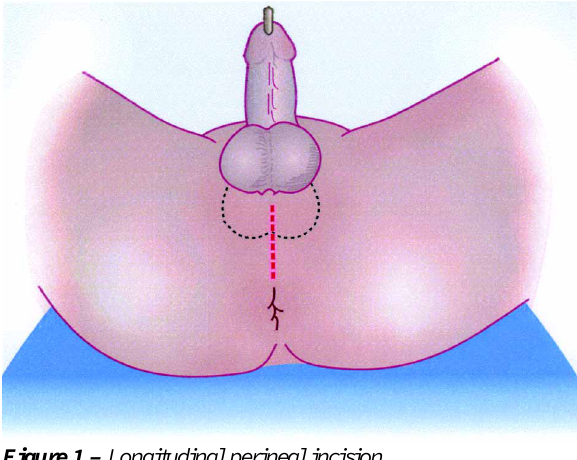
Figure 1 – Longitudinal perineal incision.